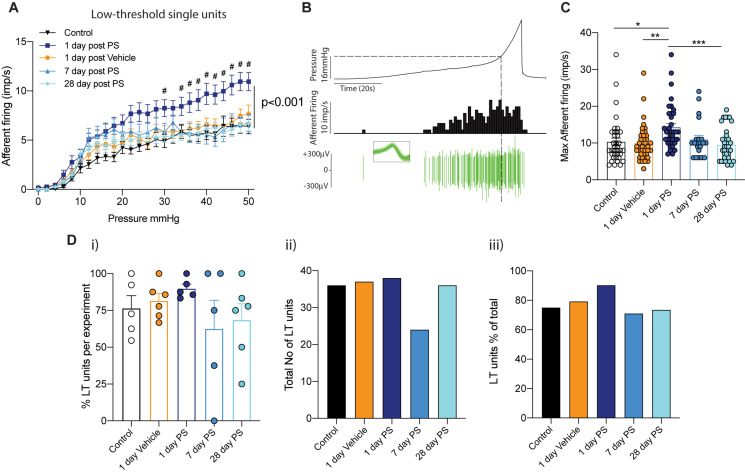
Low-threshold bladder afferent responses following in vivo protamine sulfate treatment. (A) Low-threshold bladder afferent mechanoreceptors exhibit significant hypersensitivity to bladder distension one day after in vivo infusion of protamine sulfate (PS) but not vehicle (n = 21–38 individual units from N = 5–6 mice, #P < 0.05, Two-way ANOVA with Tukey’s multiple comparisons post hoc test). (B) Example experimental trace showing a single low-threshold afferent unit in response to graded bladder distensions with saline (0–50 mmHg). Dashed line represents distinction of activation thresholds between low- and high- threshold units (16 mmHg). Individual units are determined by color spike profile (insert). (C) Peak afferent response of low-threshold bladder afferents to distension (*P < 0.05, **P < 0.01, **P < 0.001, One-way ANOVA with Tukey’s multiple comparisons post hoc test). (D) (i) The percentage of single afferent units classified as low-threshold (LT) per experiment, (ii) the total number of units classified as low-threshold (LT), and (iii), low-threshold units (LT) as a percentage of the total number of mechanosensitive units in each experimental cohort.